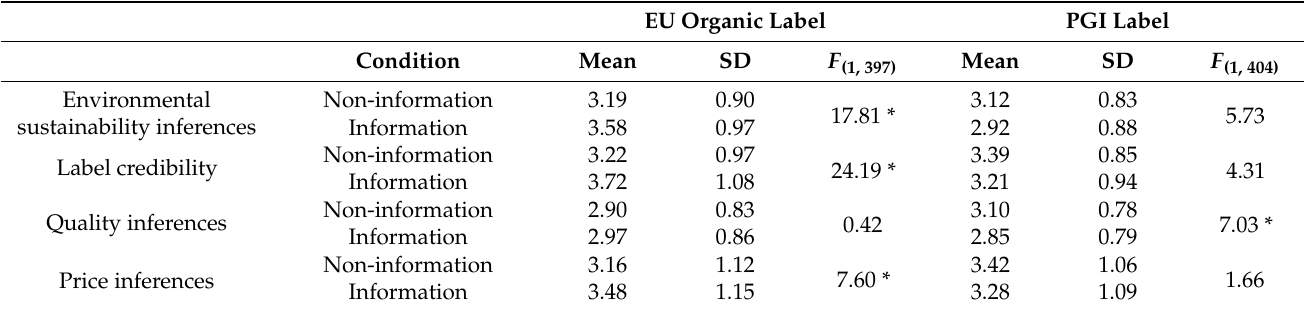
Table 4. Differences between information and non-information conditions. EU Organic